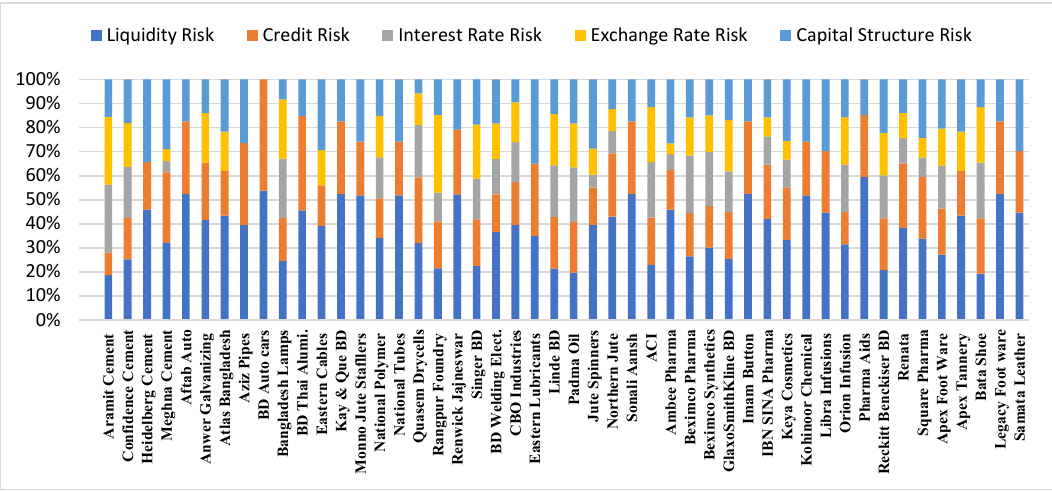
Figure 3. Composition of the disclosure indices for individual financial risks during the study period of 2010 to 2015 for each company.